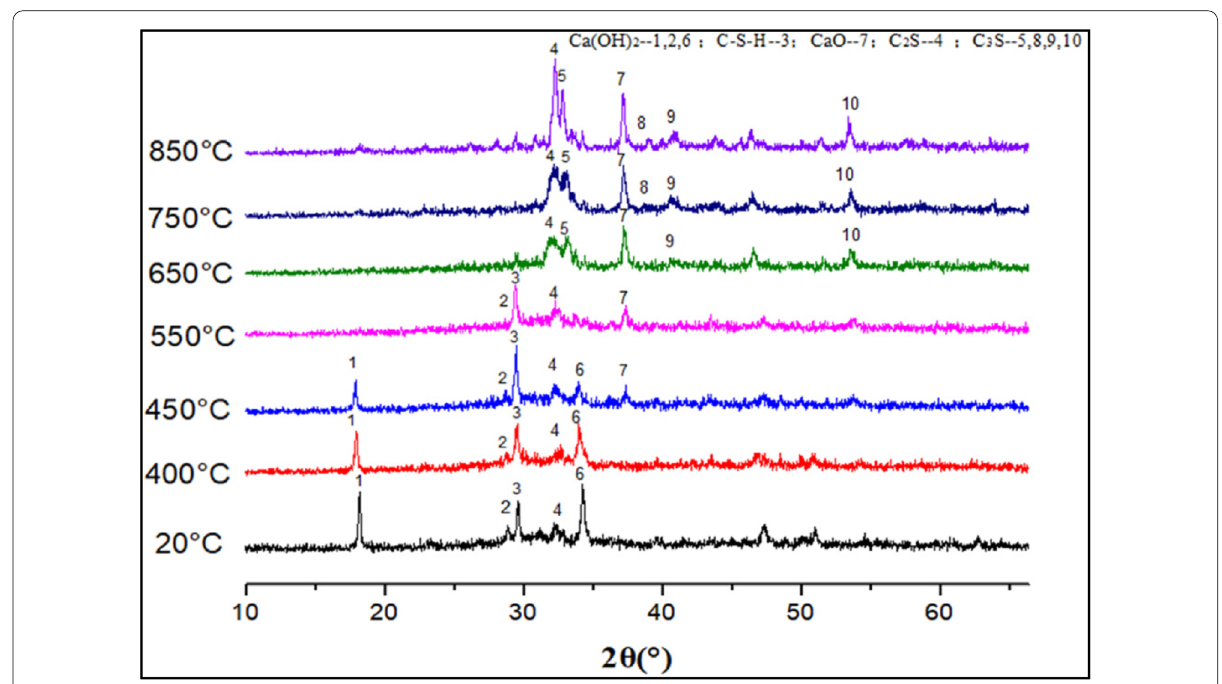
Fig. 5 XRD analysis of thermally treated WCP (Qian et al.,